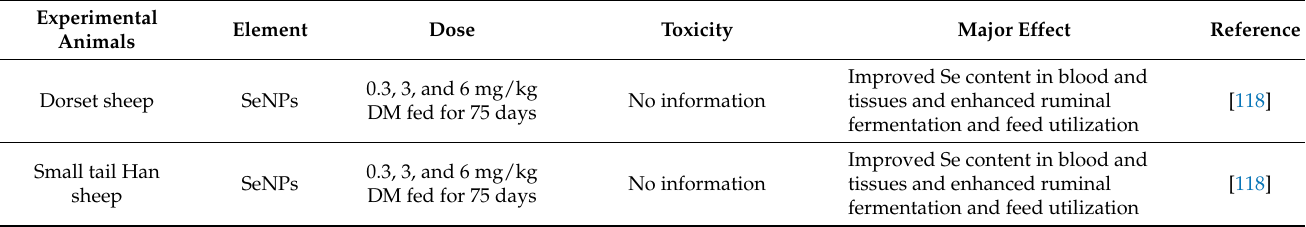
Table 3. Effect of SeNP supplementation on animal health and